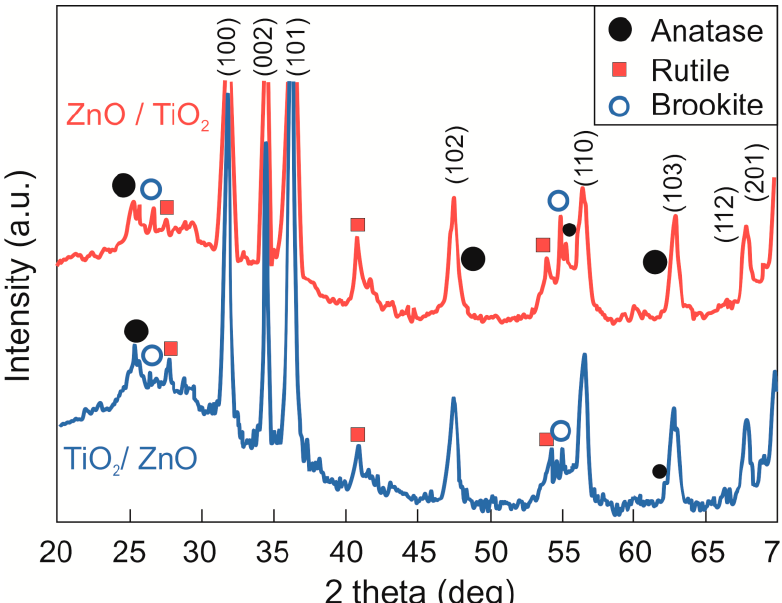
Figure 2. XRD patterns of samples ZnO/TiO 2 (red) and TiO 2 /ZnO (blue).